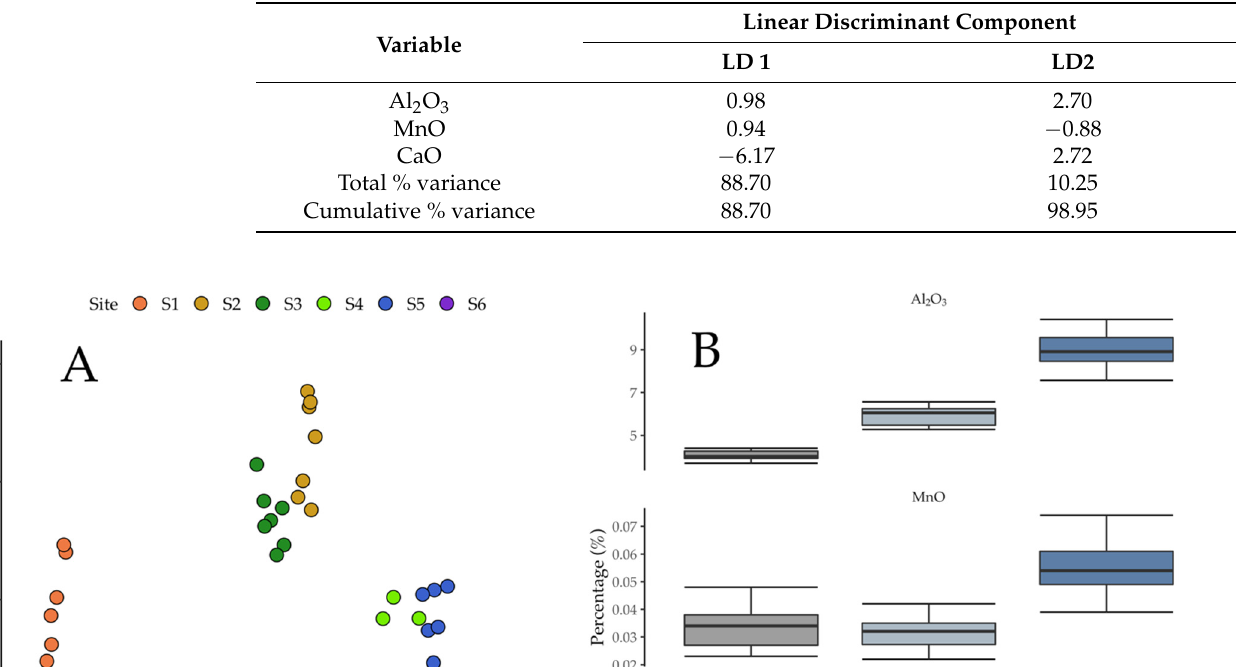
Table 2. Linear discriminant analysis of study sites discriminated according to major element composition of stored riverbed sediment.